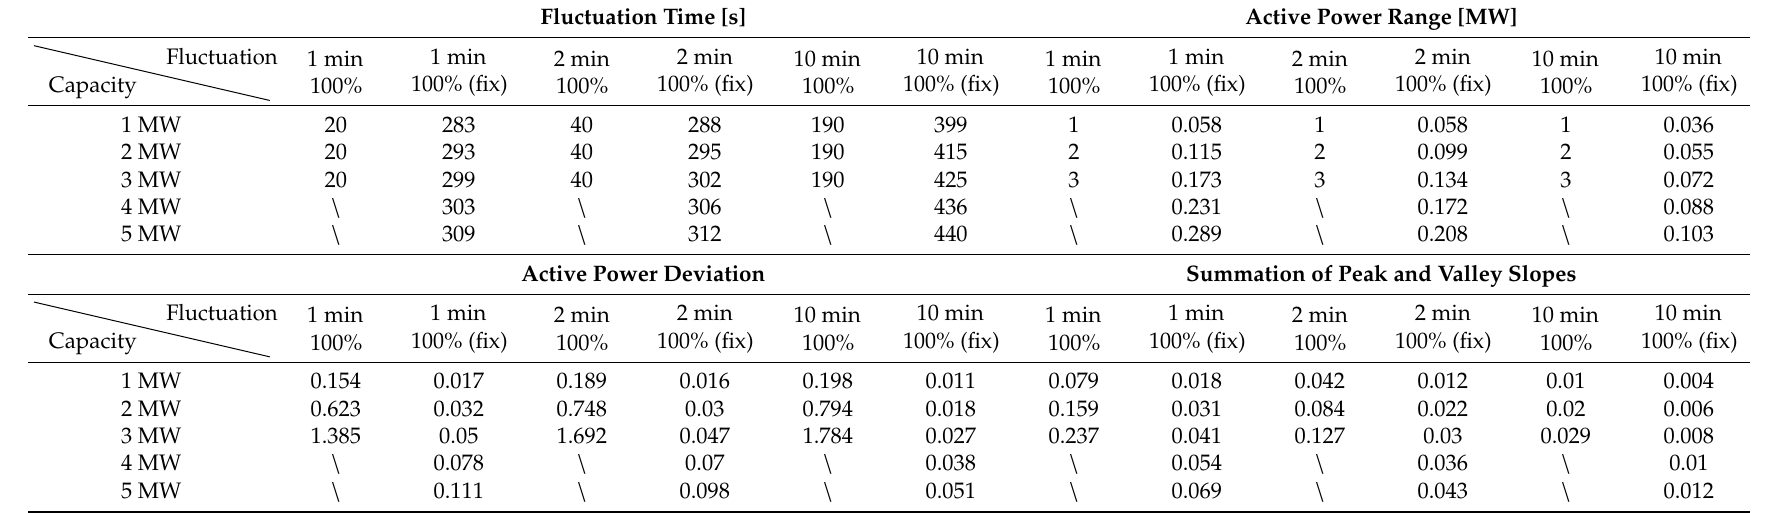
Table 6. Assessment results for a PV-HT hybrid system with 100% solar radiation